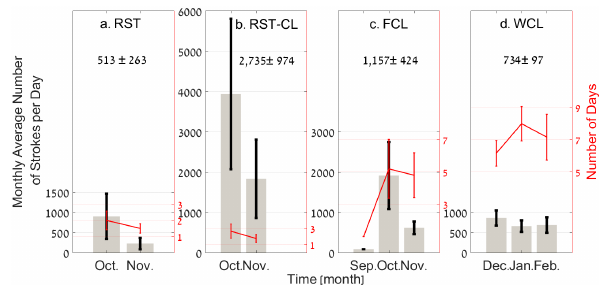
Figure 4. Interannual monthly average number of strokes per day (bar) and the average number of days (red curves) for the four synoptic systems. The error bars indicate standard errors. Seasonal perennial monthly mean and standard error are shown for each sys-